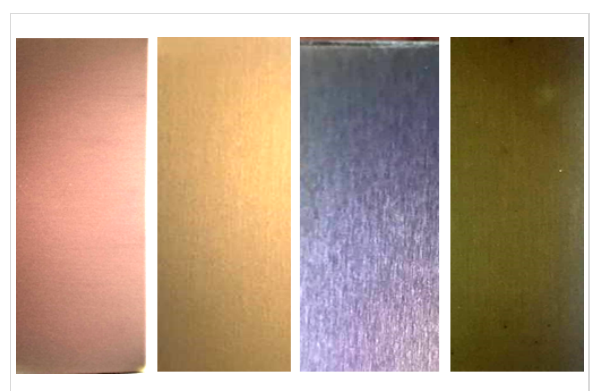
Figure 3: Digital images showing the colors of the prepared samples (from left to right: S1, S2, S3, and S4 ); the sample surface is perpen- dicular to the incident